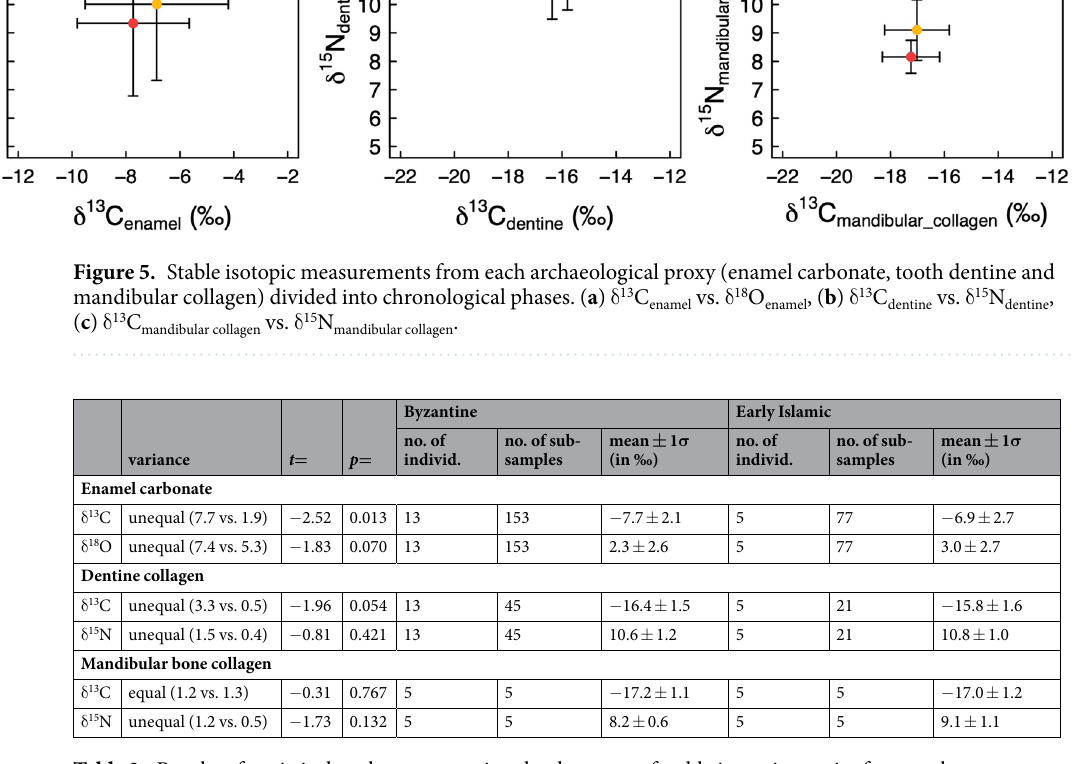
Table 2. Results of statistical analyses comparing the three sets of stable isotopic proxies from each chronological phase. Individual t-tests were carried out on each pair of δ 13 C, δ 18 O and δ 15 N values because the data came from three different datasets (enamel carbonate, dentine collagen and mandibular bone collagen), which could not be combined to carry out multi-variate